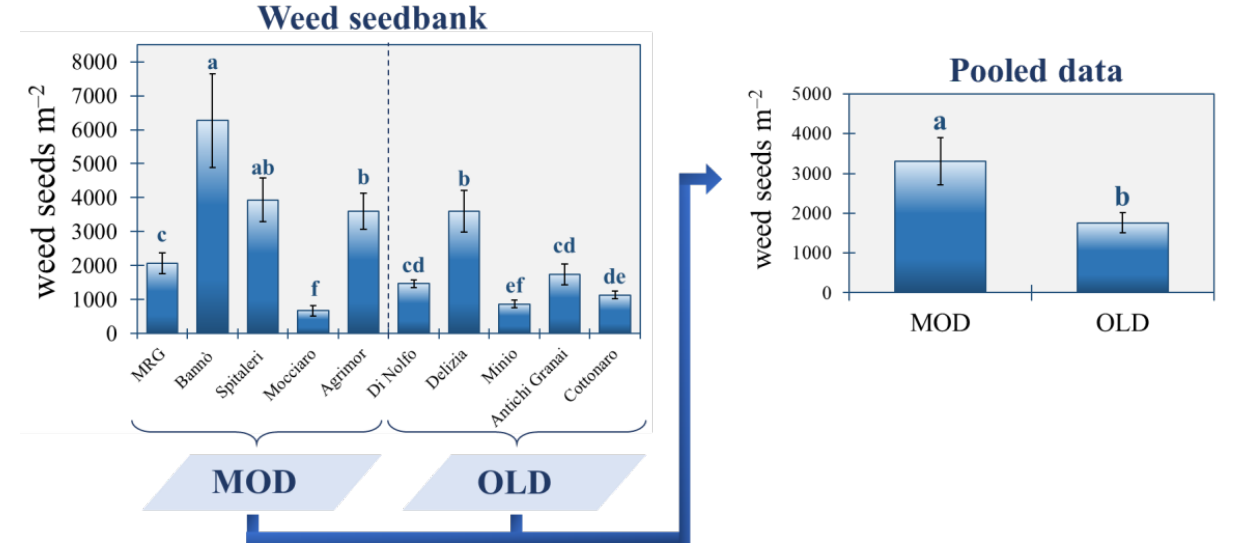
Figure 1. Size of the weed soil seedbank (0‒15 cm) across the 10 farms under study. Bars are the standard deviation ( n = 3). Different letters indicate statistical significance by applying one-way analysis of variance with Tukey’s HSD test at p < 0.05. MOD: wheat modern varieties group; OLD: wheat old landraces group.